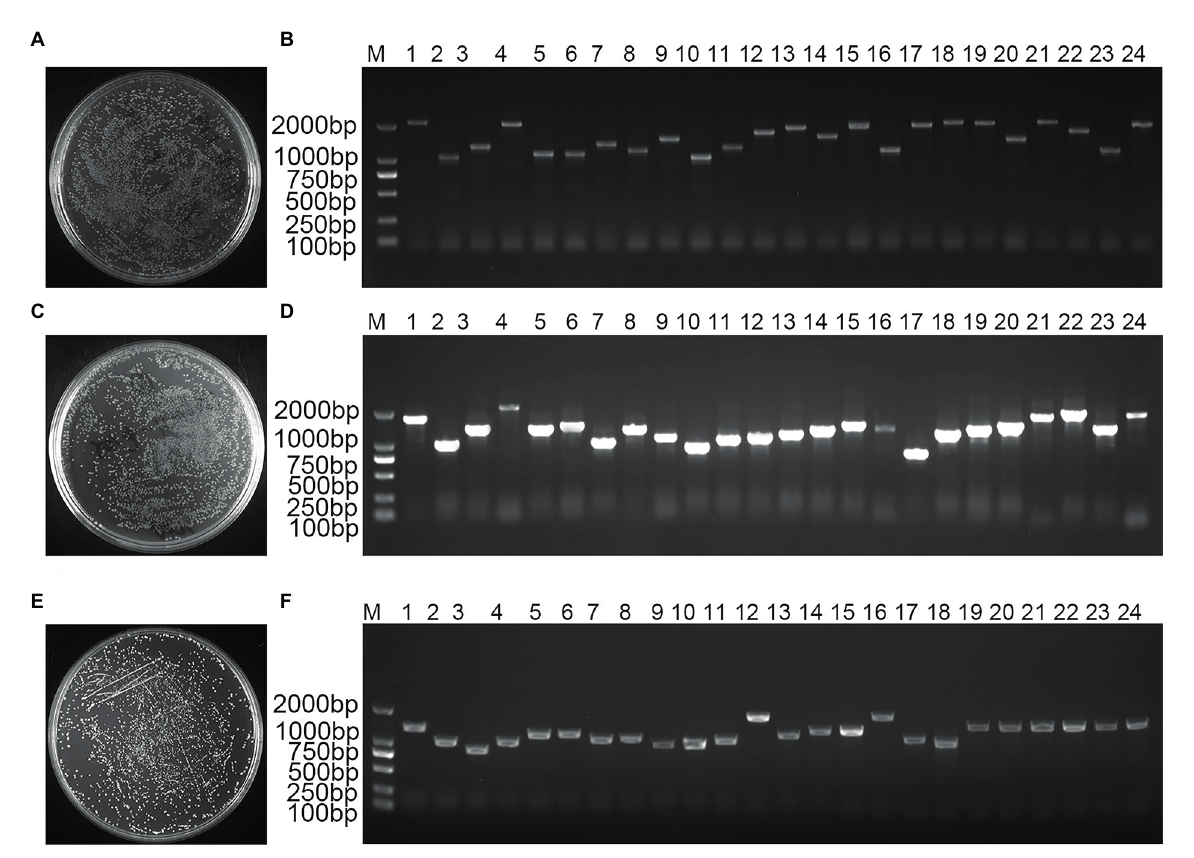
FIGURE 1 Bambusa pervariabilis × Dendrocalamopsis grandi cDNA library quality assay. (A) Primary library titer assay at 100-fold dilution; (B) PCR detection of primary library insert cDNA fragments, 1–24: 24 randomly selected single clones from the primary library; (C) secondary library titer assay at 100- fold dilution; (D) PCR for secondary library insert cDNA fragment, 1–24: 24 randomly selected monoclonal clones from secondary library; (E) Yeast working solution library titer assay at 100-fold dilution; and (F) PCR for yeast working solution insert library fragment, 1–24: 24 randomly selected monoclonal clones from yeast working solution; M: DL2000 DNA